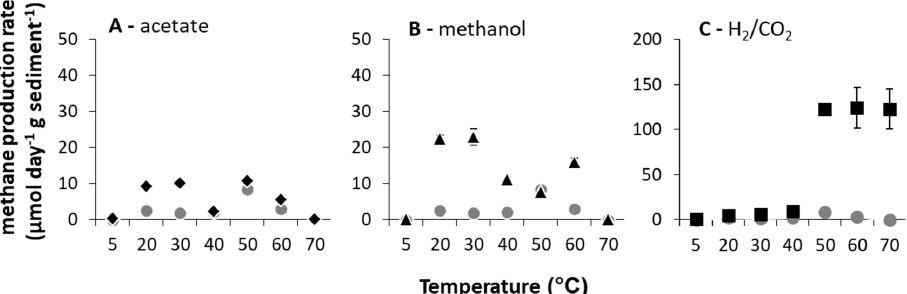
Figure 1. Methane production rates calculated between days 2 and 7 of incubation ( µ mol CH 4 g − 1 d − 1 sediment (DM) ± SE (standard error), n = 3) over the incubation temperature range of 5 to 70 °C with methanogenic substrate addition (( A ) acetate = black diamonds, ( B ) methanol = black triangles, ( C ) H 2 /CO 2 = black squares), and without substrate amendment = grey circles).